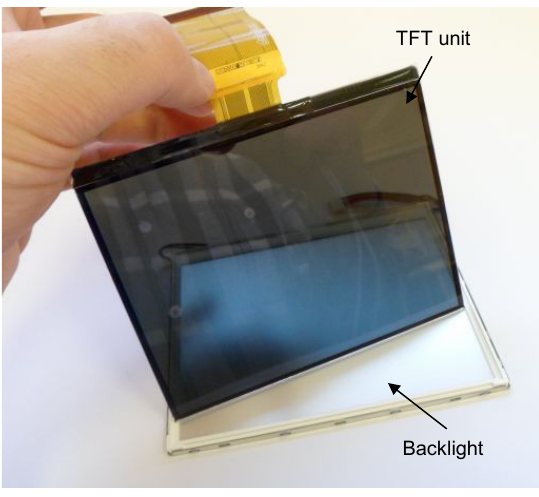
Figure 3. Disassembled TFT module.